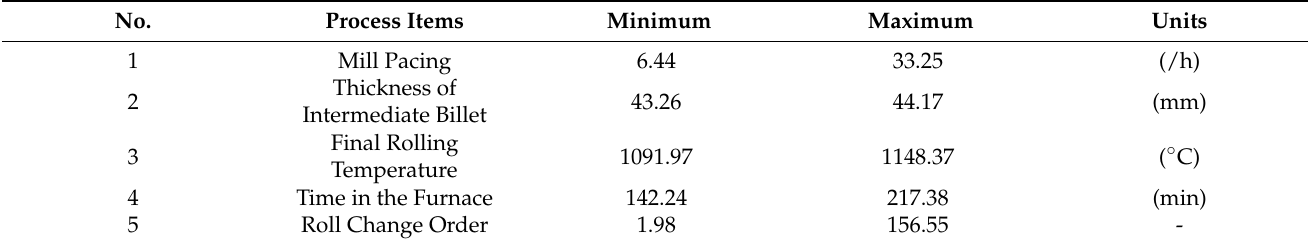
Table 6. Model optimization process